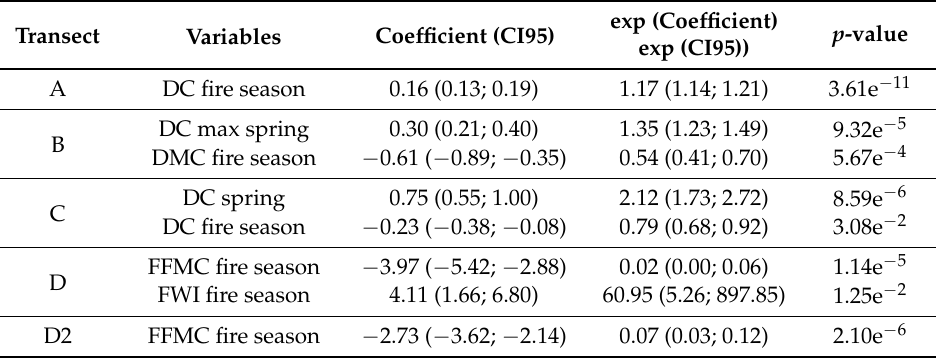
Table 2. Coefficients of models presented in Table 1. The 95% confidence interval (CI95) for each coefficient was obtained after 1000 randomizations with replacement of the original dataset. p -values and exponentiated coefficients with their CI are also